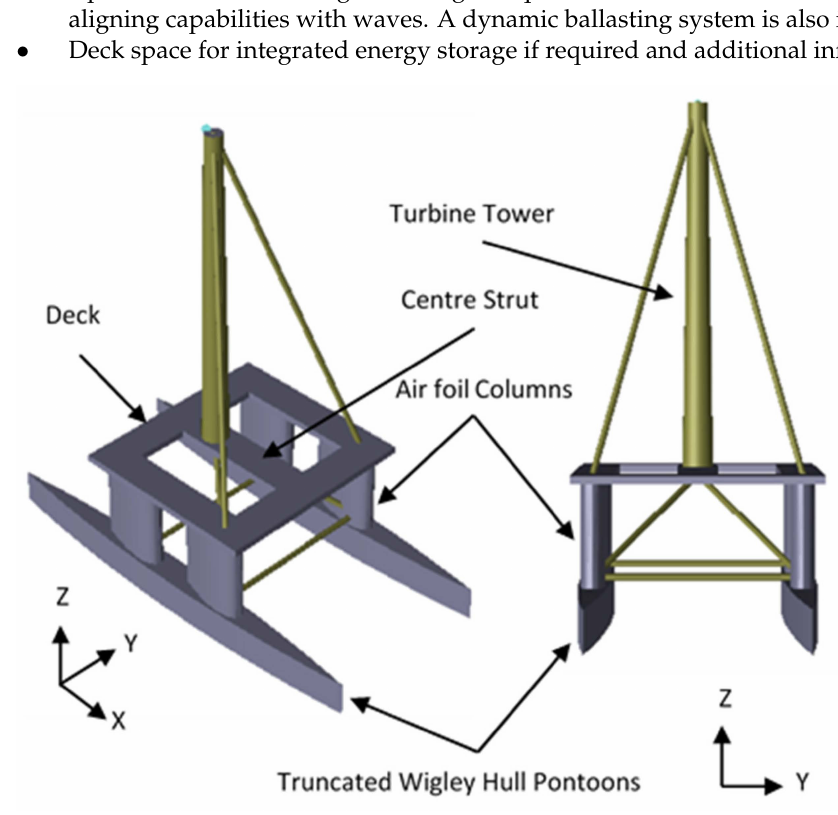
Figure 4. Proposed Model.